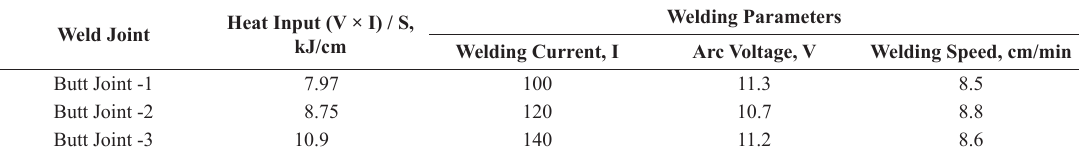
Table 2. Welding parameter used for present investigation Weld